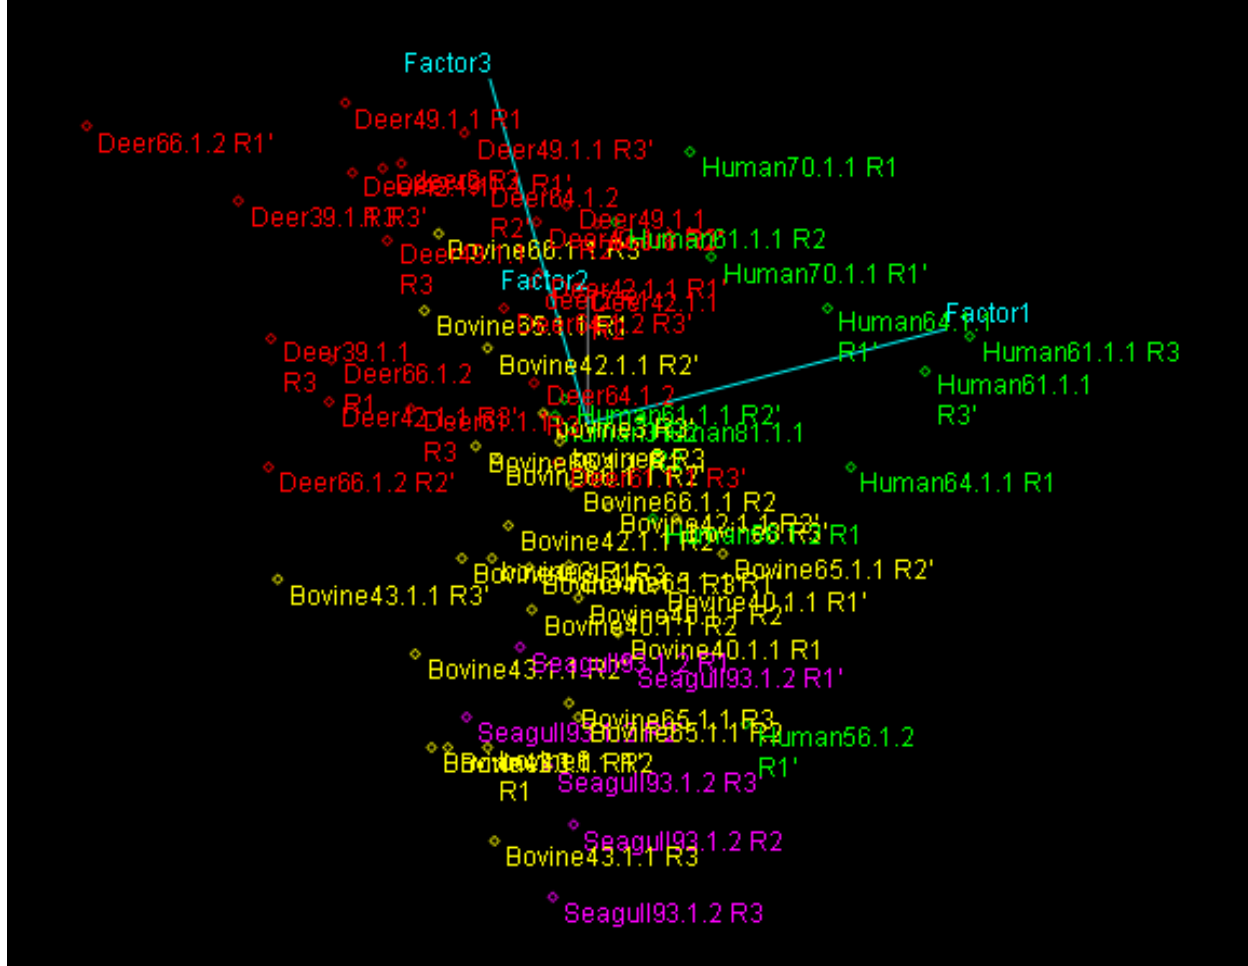
Figure 5: Principal Components Analysis of normalized microarray spot intensities of replicates of 17 environmental isolates of Enterococcus sp. , colored by host origin: deer is red, bovine is yellow, human is green, gull is purple. For this 3D view only the first 3 components can be plotted, but clustering is